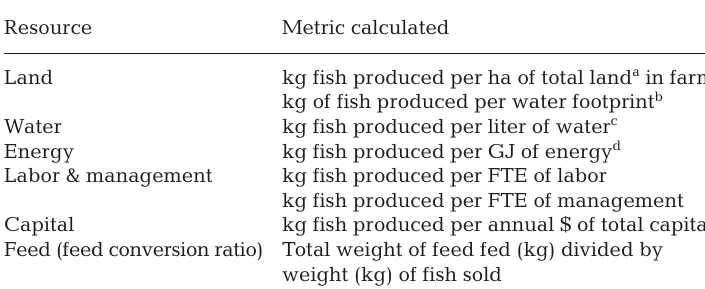
Table 1. Calculations of resource-use efficiency metrics. FTE: full-time equivalent